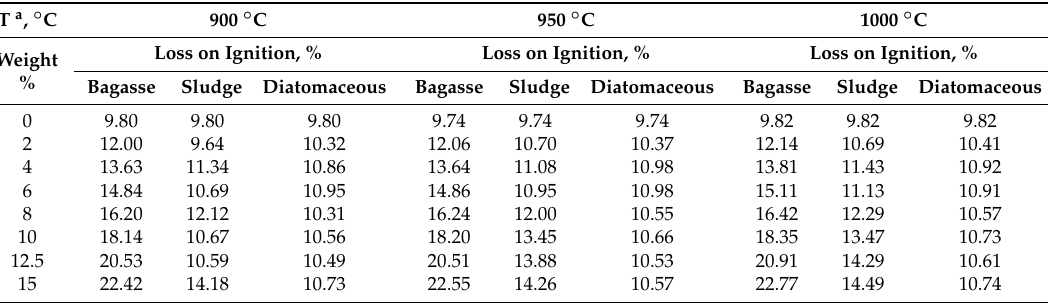
Table 3. Loss on ignition in sintered